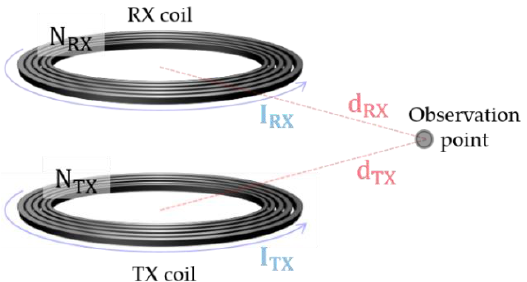
Figure 3. The magnetic field strength generated by the TX coil and RX coil.